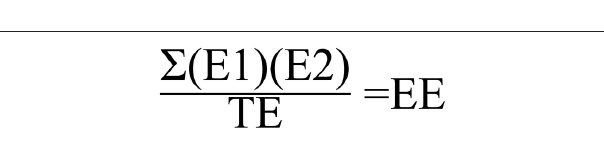
FIGURE 2 | Scoring formula for exon-to-exon overlaps. E1, Proportion of Exon within Gene 1 overlapping with Exon within Gene 2. E2, Proportion of Exon within Gene 2 overlapping with Exon within Gene 1; TE, Total number of unique exons from both genes; EE, Exon Exon overlap